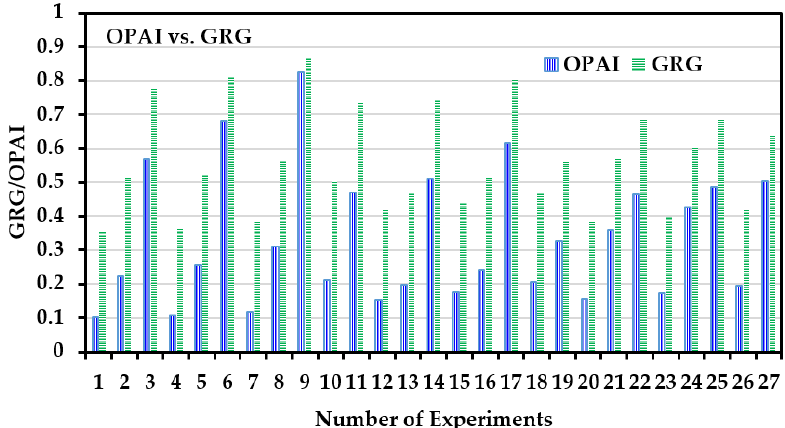
Figure 4. Comparison of the Overall Performance Assessment Indicator (OPAI) and the grey relational grade (GRG) for case study 1.